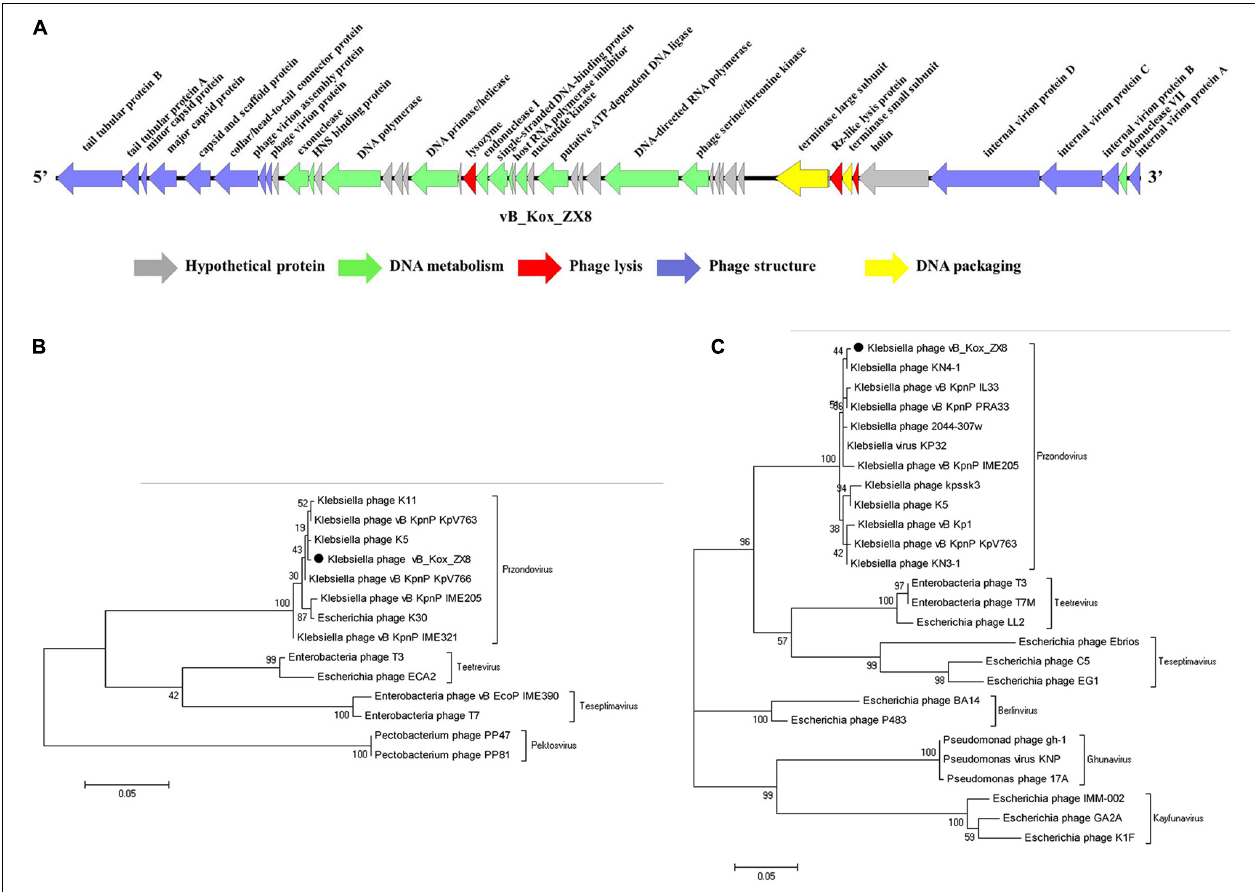
FIGURE 3 | Genome analysis of phage vB_Kox_ZX8. (A) Linear genome map of phage vB_Kox_ZX8. Phylogenetic trees of the (B) terminase large subunit, and the (C) major capsid protein of phage vB_Kox_ZX8.